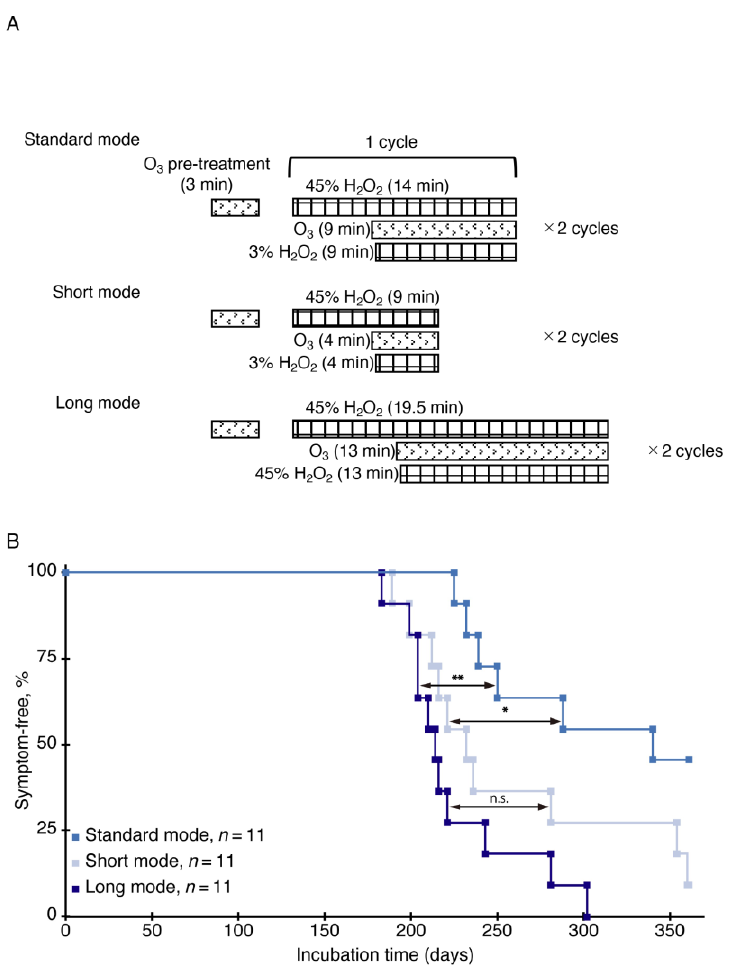
Figure 4. Sterilization of RML prions fixed on stainless steel wires in different sterilization modes. ( A ) Schematic representations of the sterilization protocols of ozone gas mixed with vaporized hydrogen peroxide in the standard, the short, and the long modes. RML prions-fixed wires were pre-treated by injection of 25,000 ppm ozone gas for 3 min and followed by 2 cycles of a 14-min sterilization process comprising injection of 45% hydrogen peroxide followed by injection of 25,000 ppm ozone gas and 3% hydrogen peroxide 5 min later in the standard mode, a 7-min sterilization process comprising injection of 45% hydrogen peroxide followed by injection of 25,000 ppm ozone gas and 3% hydrogen peroxide 5 min later in the short mode, and a 19.5-min sterilization process comprising injection of 45% hydrogen peroxide followed by injection of 25,000 ppm ozone gas and 45% hydrogen peroxide 6.5 min later in the long mode. The sterilization process of each mode was terminated by injection of air. ( B ) The percentage of symptom-free mice after intracerebral implantation with RML prion-contaminated stainless steel wires exposed to ozone gas mixed with vaporized hydrogen peroxide-exposed in the standard, the short, and the long modes. O 3 , ozone; H 2 O 2 , hydrogen peroxide; * p < 0.05; ** p < 0.01; n.s., not significant.